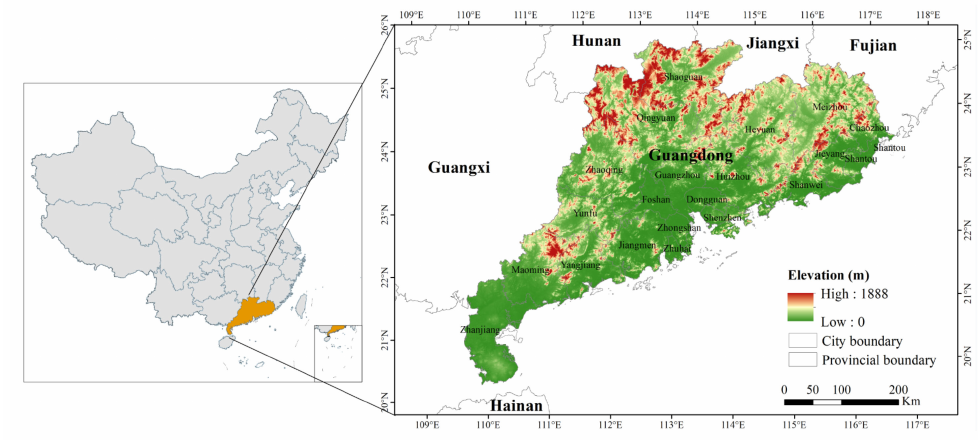
Figure 1. Geographical location of Guangdong province,